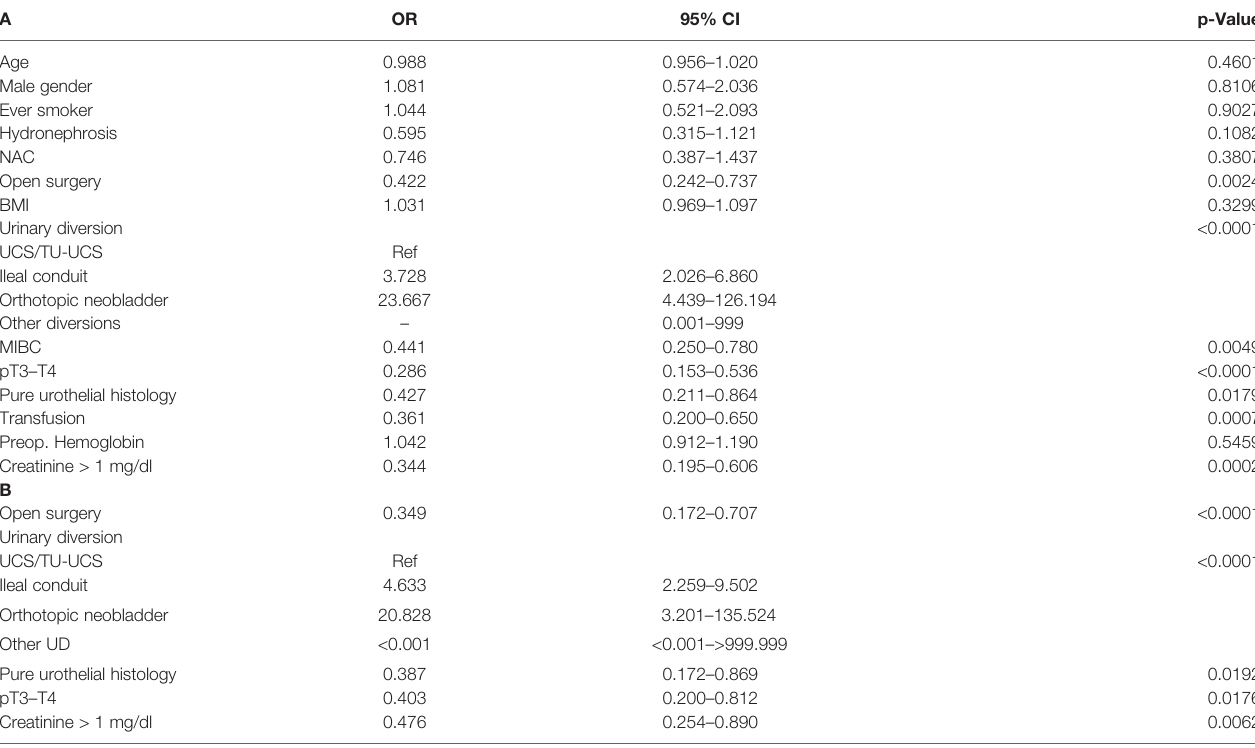
TABLE 5 | Factors in fl uencing pentafecta achievement: univariate (A) and multivariate analysis (B).